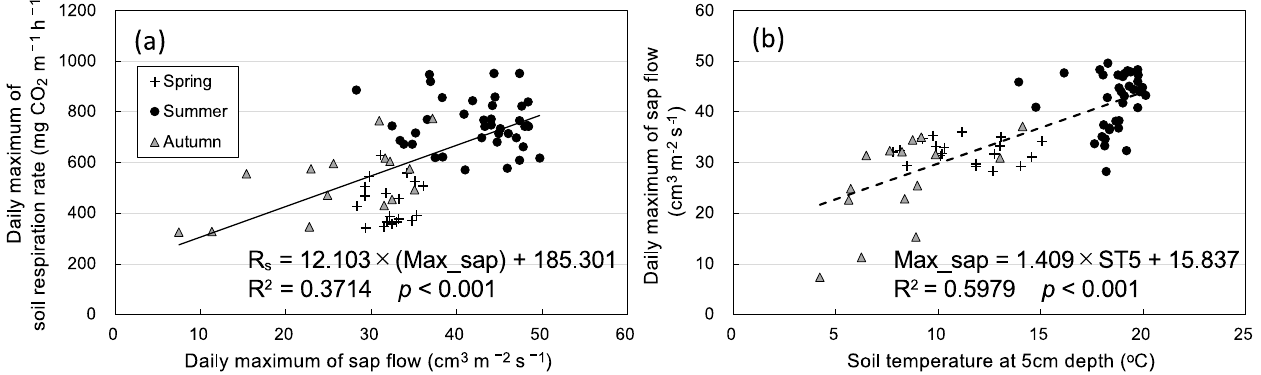
Figure 6. Relationship between daily maximum sap flow (Max_sap) and ( a ) daily maximum soil respiration rate and ( b ) daily mean soil temperature at a depth of 5 cm on sunny days only in three seasons. The daily maximum sap flow and soil respiration were calculated as the average values of two samples on the same day.